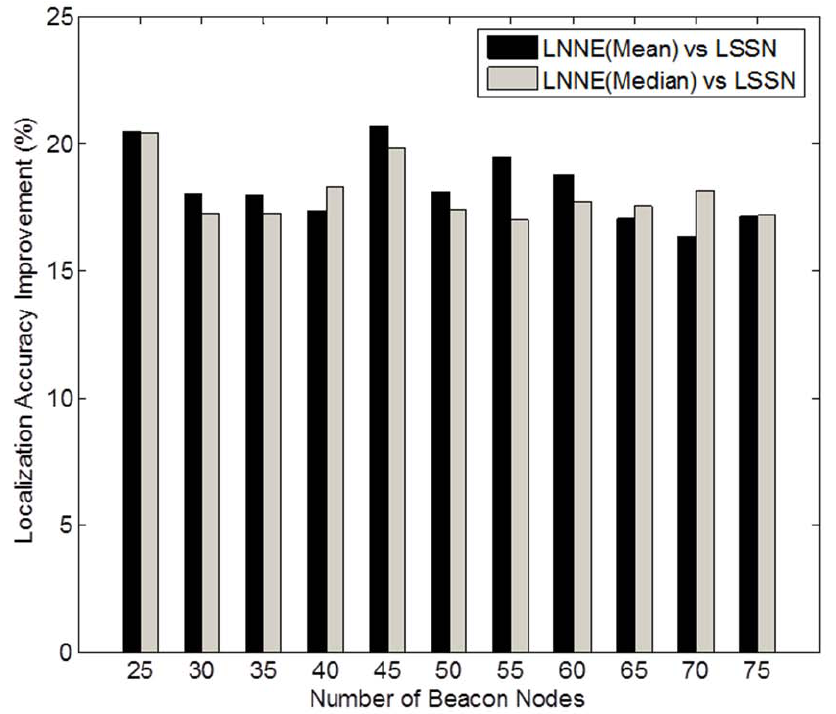
Figure 5. Performance improvement of LNNE vs. LSSN ( N = 250, beacon ratio = 0.1–0.3, no coverage holes).